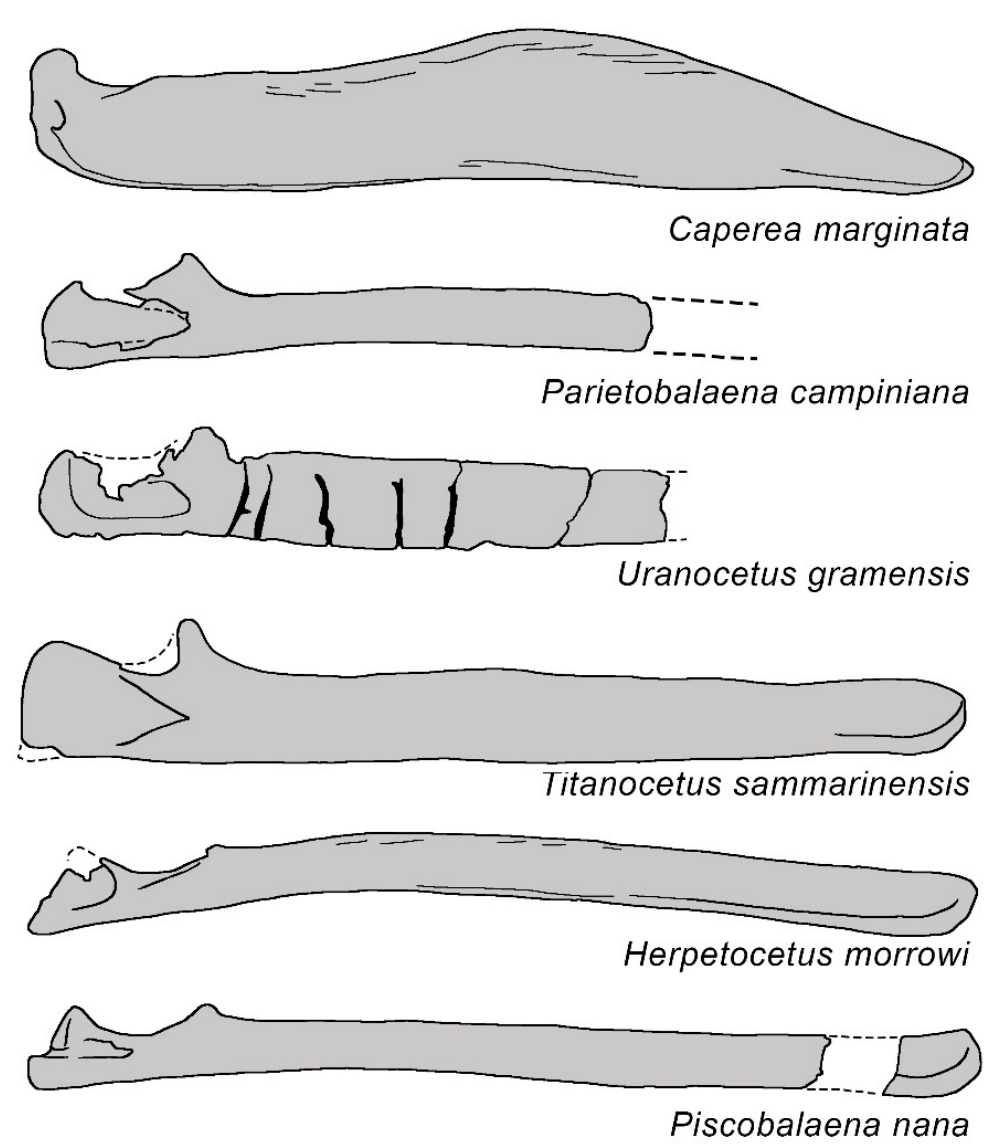
Figure 19. Schematic representations of the dentary in Balaenomorpha in medial view. Not to scale. Dentaries are represented as if they shared the same anteroposterior length.